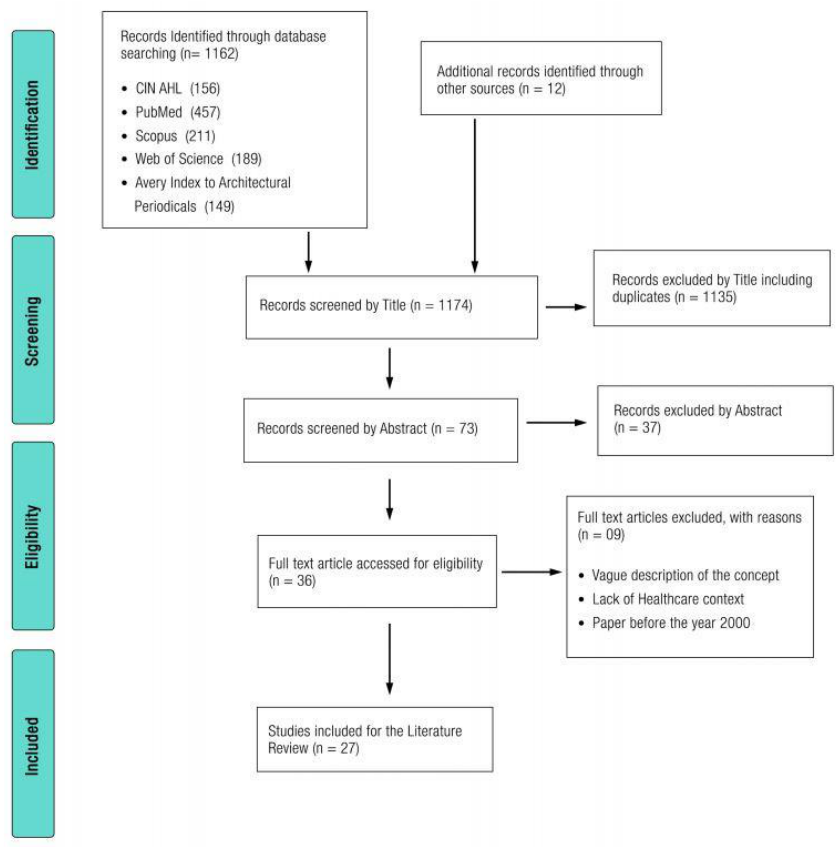
Figure 1. The PRISMA Flow Diagram shows the process followed for the identification of the 23 papers selected through the Literature